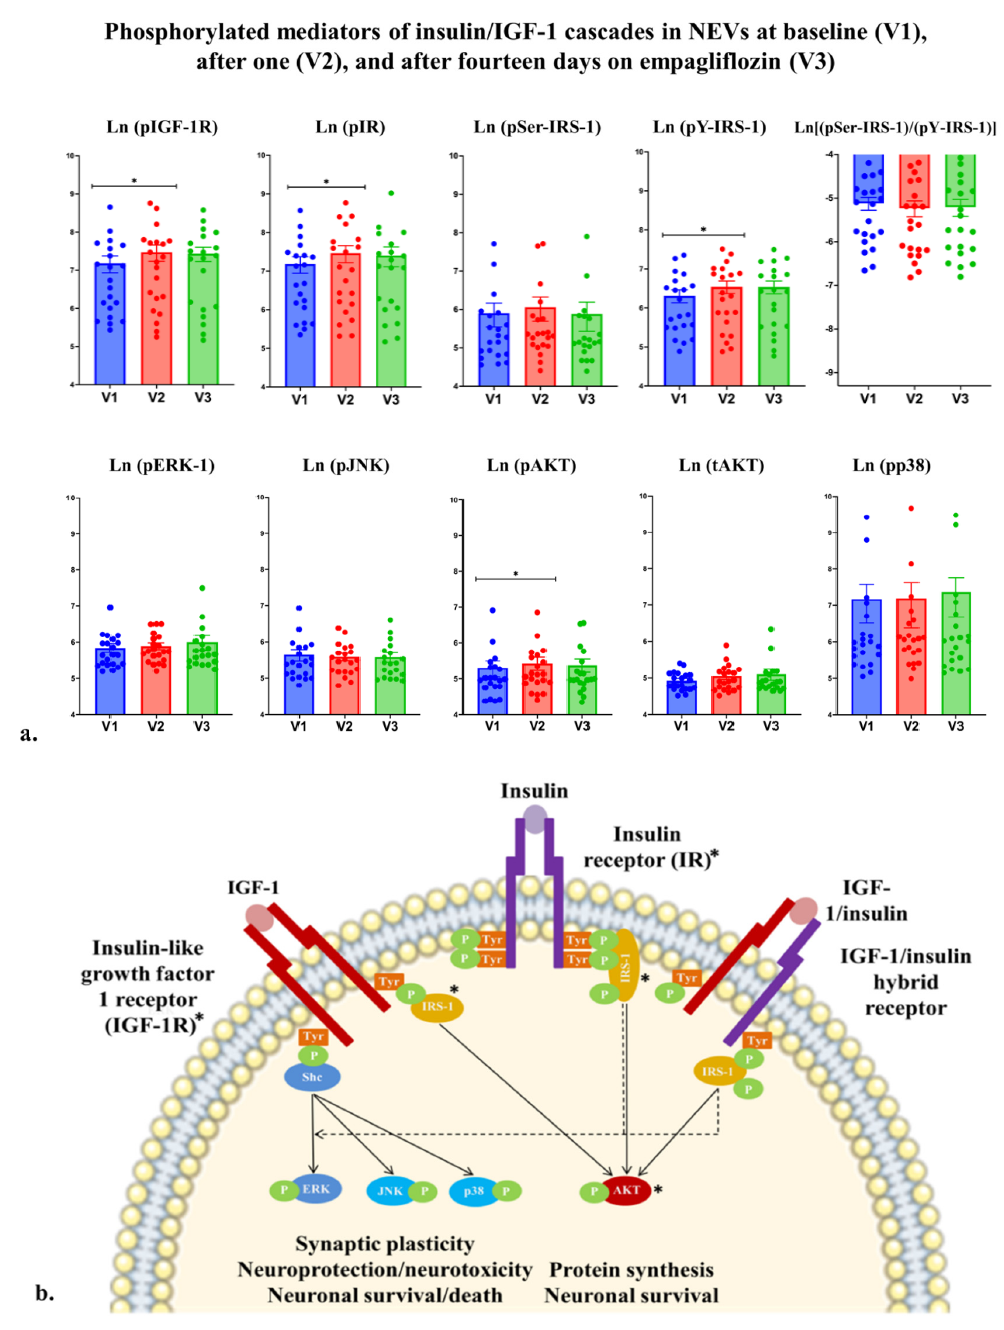
Figure 3. ( a ). means (SE) of phosphorylated ( p ) and total (t) levels of IGF-1/insulin Figure 3. Left(a):. means (SE) of phosphorylated ( p ) and total (t) levels of IGF-1/insulin cascade-associated proteins measured in extracellular vesicles enriched for neuronal origin (NEVs) at baseline (visit 1 t 0 (V1)), 24 h after the first dose (visit 2 t 24 (V2)), and 24 h after the last dose (visit 3 t 24 (V3)). Statistical analysis involved repeated-measures linear mixed models with “Visit” as the repeated-measures variable and additional variables as